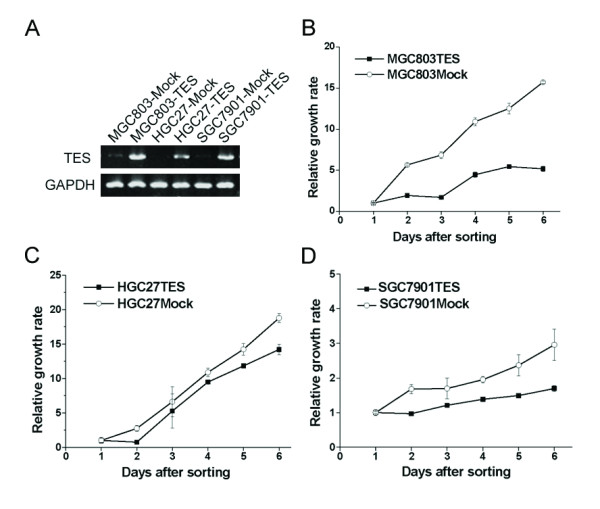
Overexpression of TES and its inhibitory effect on the proliferation of GC cells. Three GC cell lines used in this study were MGC803, HGC27 and SGC7901. A. TES mRNA expression in GC cells 36 h after transfection. B-D. The inhibitory effect of TES overexpression on the proliferation of GC cells sorted by flow cytometry for 7 consecutive days. This experiment is a representative of three independent experiments.